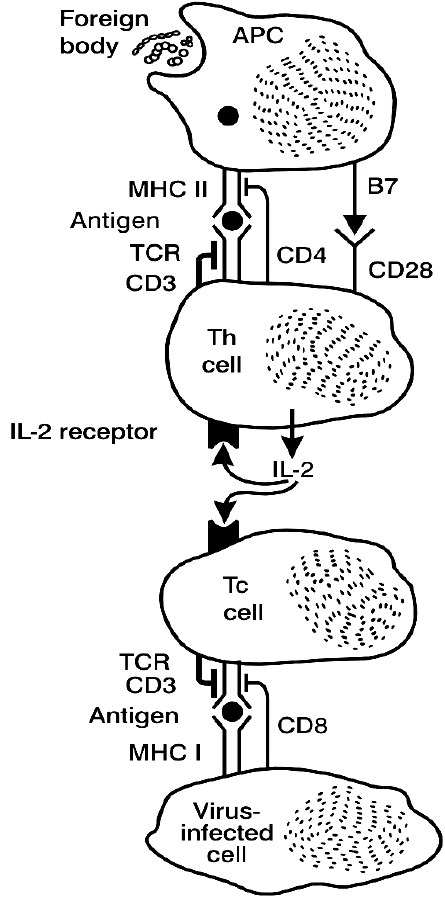
Figure 1: Th/Tc cell activation - Antigen (foreign body) is phagocytosed by antigen presenting cell (APC). Antigen is presented on MHCII and seen by TCR on Th cell. “Costimulatory signal” is induced by interaction of B7 and B28. Activated Th cell produces IL-2 and γ interferon. Tc cell Activation: Endogenously synthesized (viral or self) proteins are presented on MHCI and seen by TCR on Tc cell to kill virus- infected cell. Autocrine and paracrine effects of IL-2 as well as cell-cell contact stimulation are